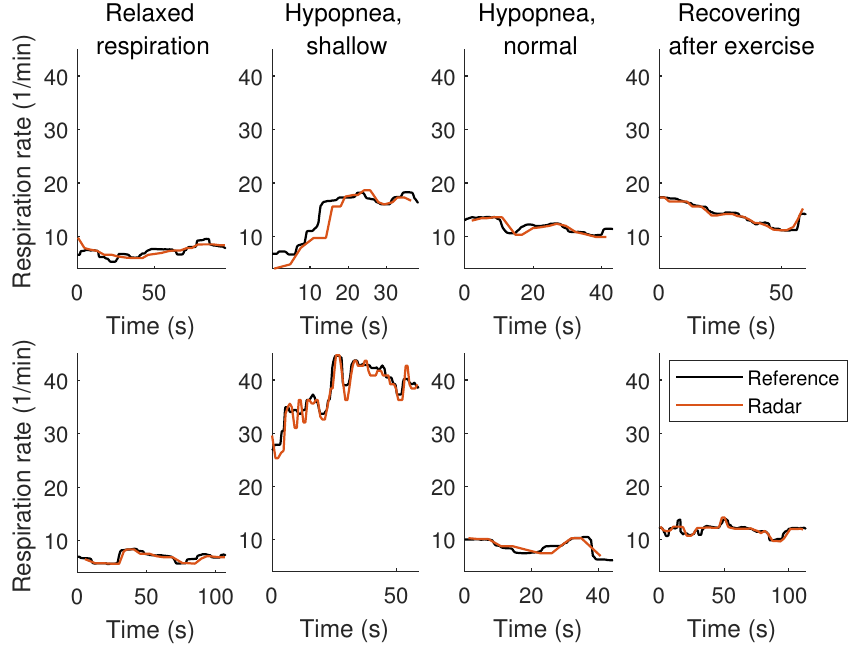
Figure 8. Respiration signal samples of two participants (ID003 on the top, ID011 on the bottom) for each activity in the supine lying position.